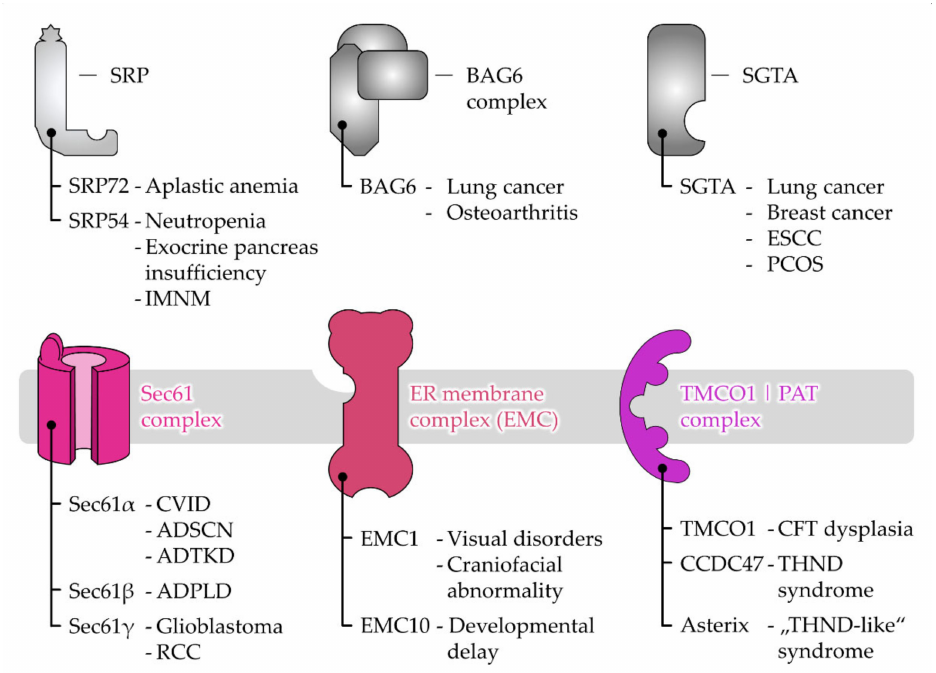
Figure 6. Disease associations of selected targeting and translocation components. The cartoon summarizes disease associations for critical subunits of targeting factors and translocation machines. Further details can be found in the text. ADPLD, autosomal dominant polycystic liver disease; ADSCN, autosomal dominant severe congenital neutropenia; ADTKD, autosomal dominant tubulo- interstitial kidney disease; CFT dysplasia, cerebro-facio-thoracic dysplasia; CVID, common variable immunodeficiency, ESCC, esophageal squamous cell carcinoma; IMNM, immune-mediated necro- tizing myopathy; PCOS, polycystic ovary syndrome; RCC, renal cell carcinoma; THND syndrome, tricho-hepato-neuro-developmental